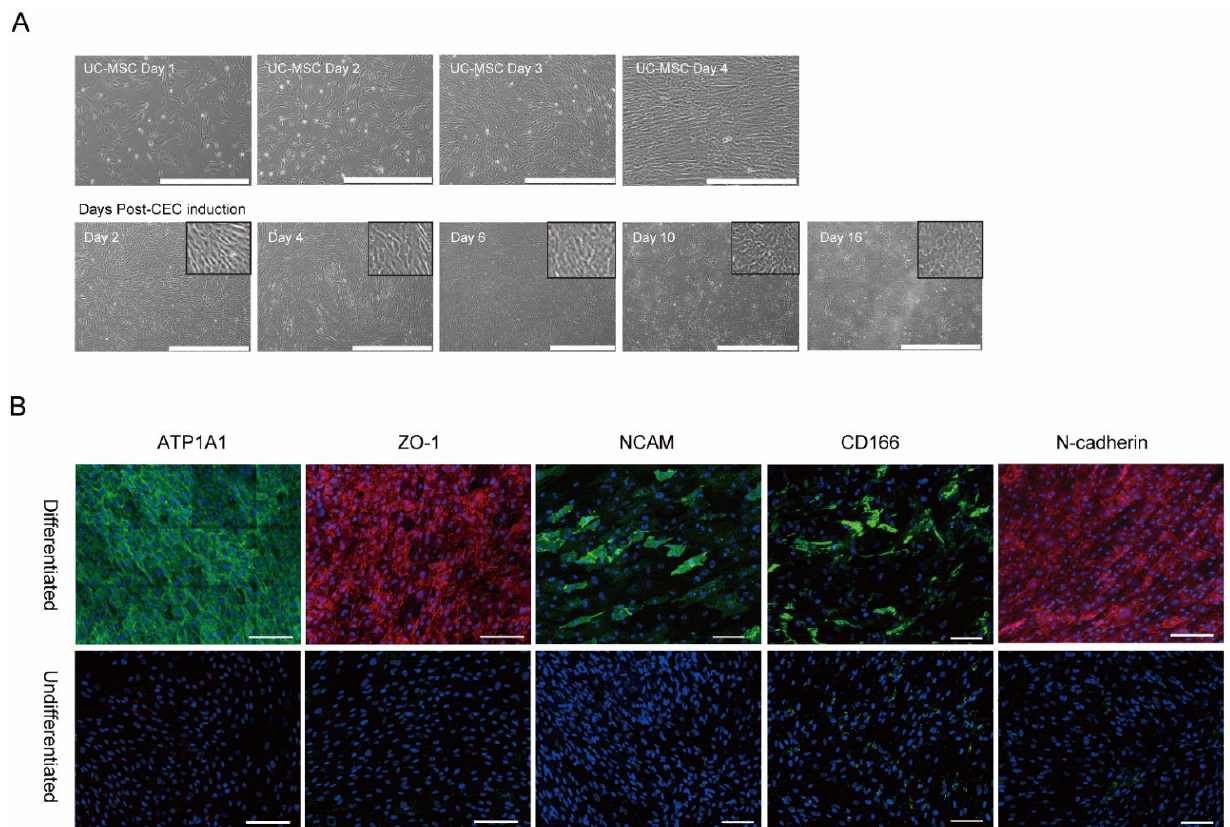
Figure 1. Generation of corneal endothelial cells from umbilical cord-derived mesenchymal stem cells. ( A ) Phase-contrast microscopic images taken from days 1 to 4 of UC-MSC culture and taken 2, 4, 6, 10, and 16 days after CEC induction. Scale bars = 1 mm ( upper ) or 500 µm ( lower ). ( B ) Immuno- cytochemistry of pump function protein Na + /K + ATPase α 1 (ATP1A1), zona occludens-1 (ZO-1; a tight-junction protein), NCAM (CD56), CD166, and N-cadherin as characteristic markers of CECs at 16 days after CEC induction. Cell nuclei were counterstained with DAPI. Scale bars = 100 μm.